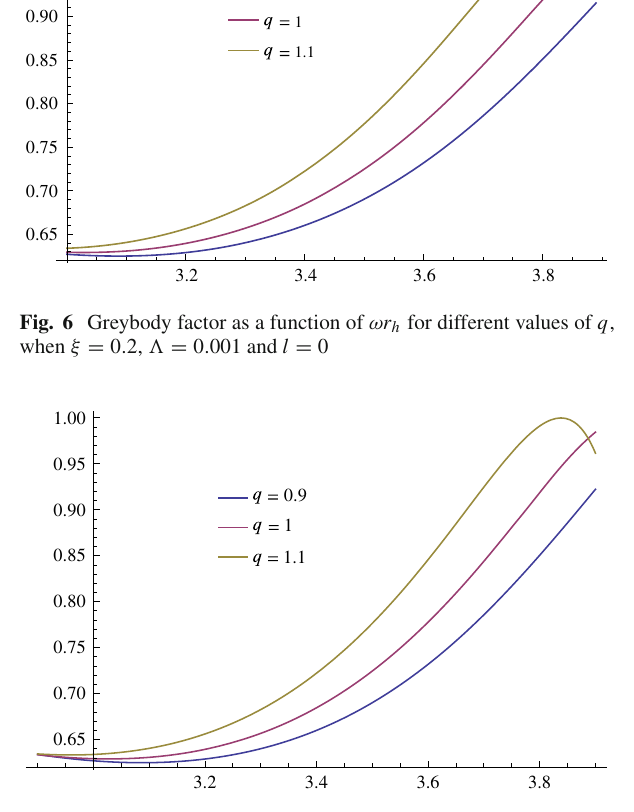
Fig. 7 Greybody factor as a function of ω r h for different values of q , when ξ = 1, (cid:5) = 0 . 001 and l = 0